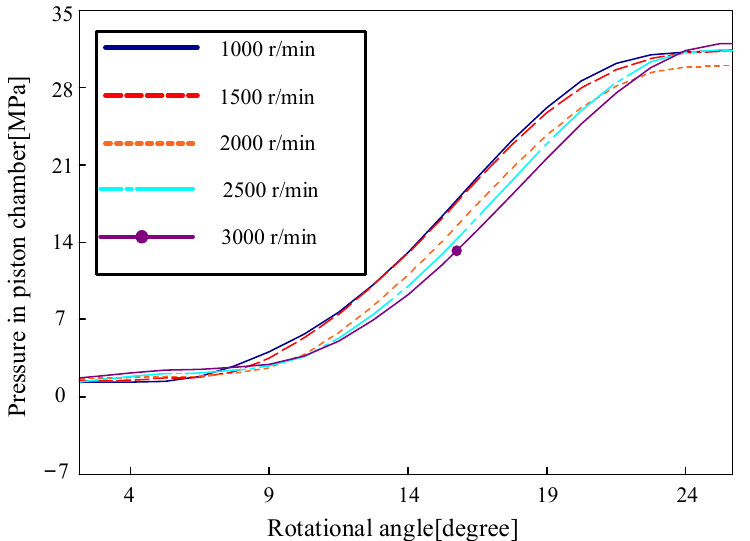
Figure 16. Pressure in the piston chamber with different rotational speeds at the beginning of the discharge phase.